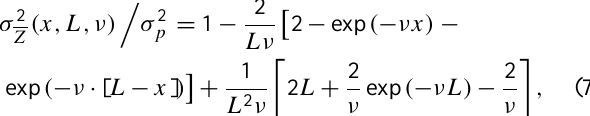
associated with multiple measurement designs for profiles and fields of snow